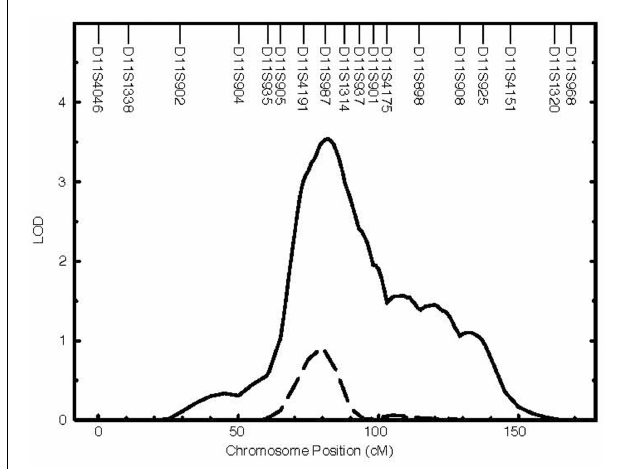
FIGURE 2 | Genome-wide linkage analysis for erythrocyte D5D localizes a QTL on chromosome 11. The QTL for plasma and erythrocyte D5D estimates on chromosome 11. Solid line, erythrocyte D5D (LOD = 3.5 at 82cM); dashed line, plasma D5D (LOD = 0.9 at 81cM).